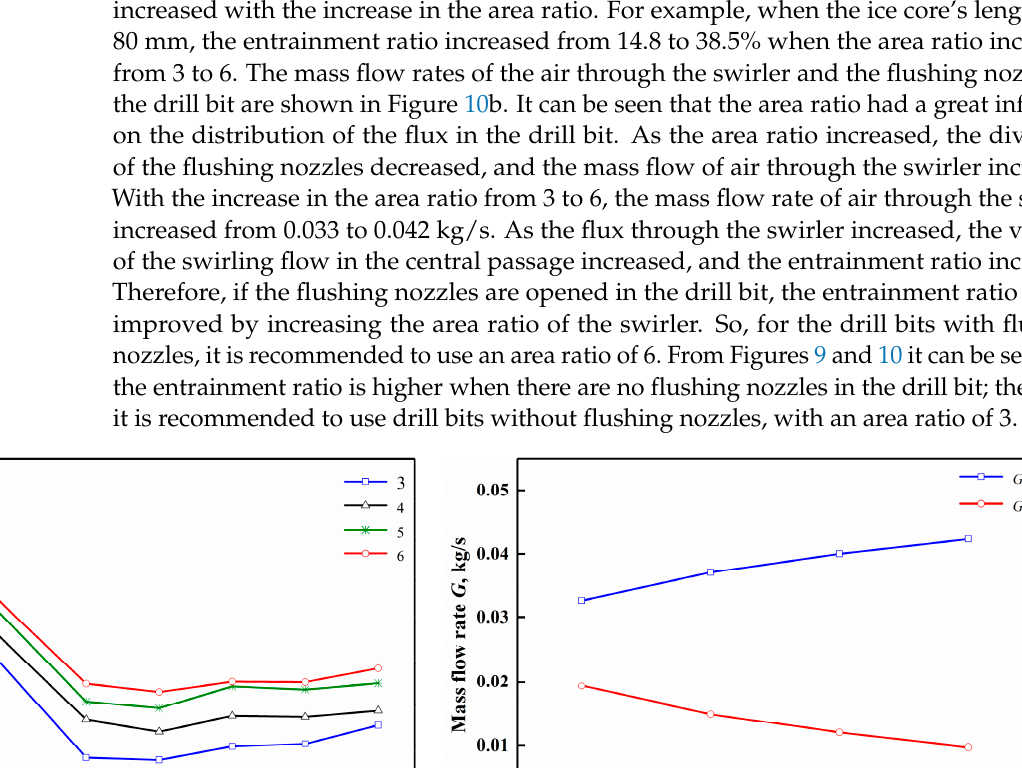
Figure 9. Drill bits without the flushing nozzles: ( a ) influence of helical angles on entrainment ratio; ( b ) maximum velocity of gas at the outlet of swirler.